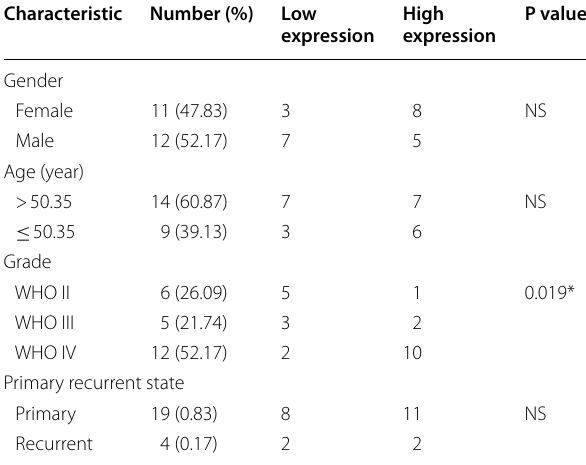
Table 1 Characteristics of patients with glioma based on clinical